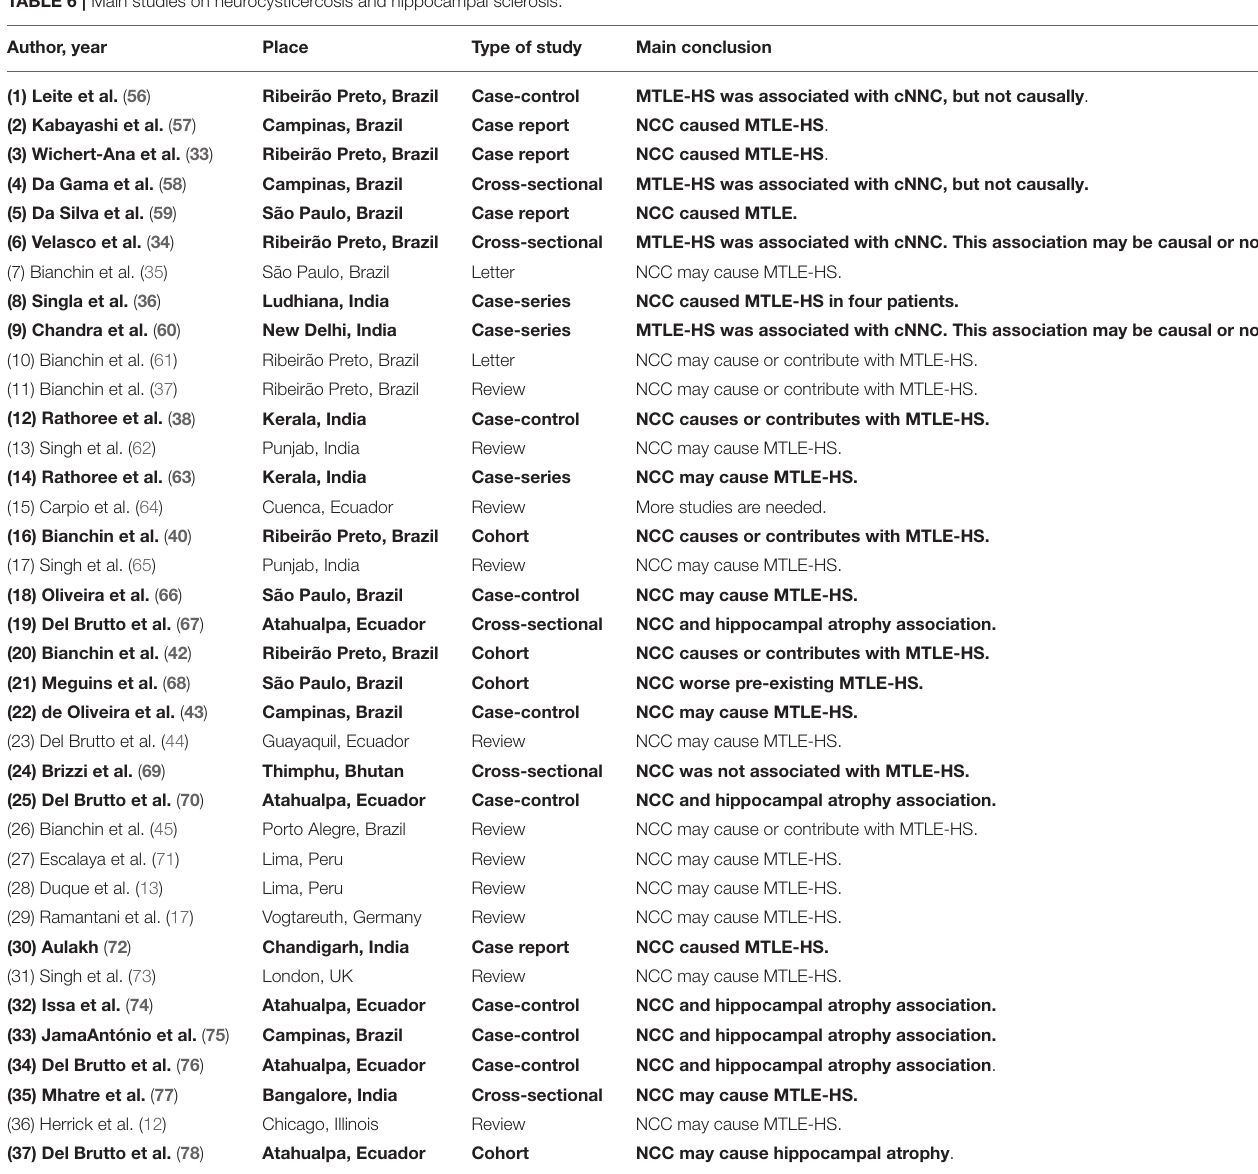
TABLE 6 | Main studies on neurocysticercosis and hippocampal sclerosis. Author,